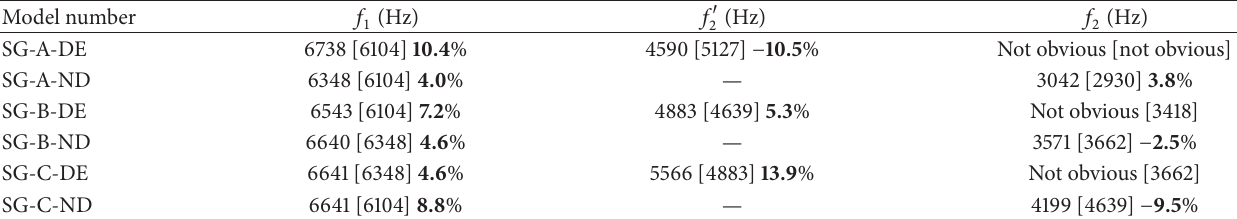
Table 6: Comparison of peak frequency between test results and finite element simulation under different working conditions.